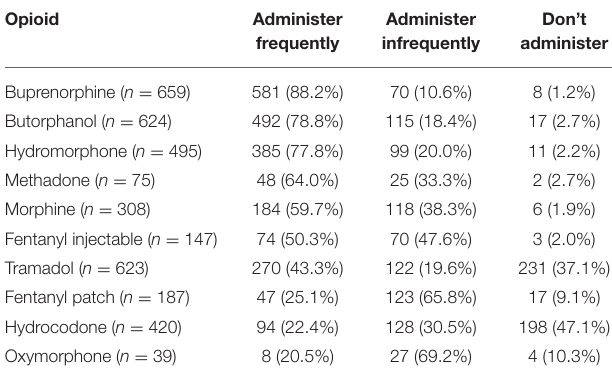
TABLE 2 | Veterinarians’ reported frequency of prescribing specific opioids in veterinary practice. Opioid